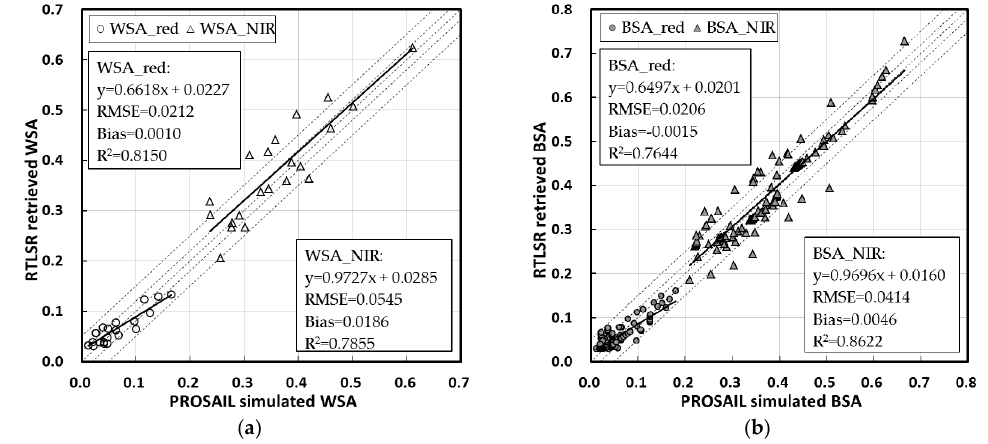
Figure 8. Comparison of simulated and inversion-based albedos for observations, where the two gray dashed lines show the 0.02 and 0.05 tolerances, respectively: ( a ) WSA comparison in the red and NIR bands; ( b ) BSA comparison in the two bands.